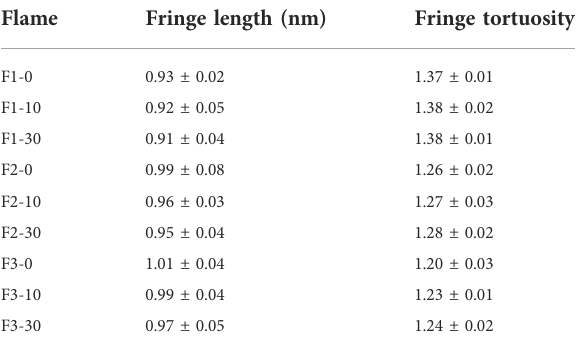
TABLE3Meanfringelengthandtortuositywithstandarddeviationsof the